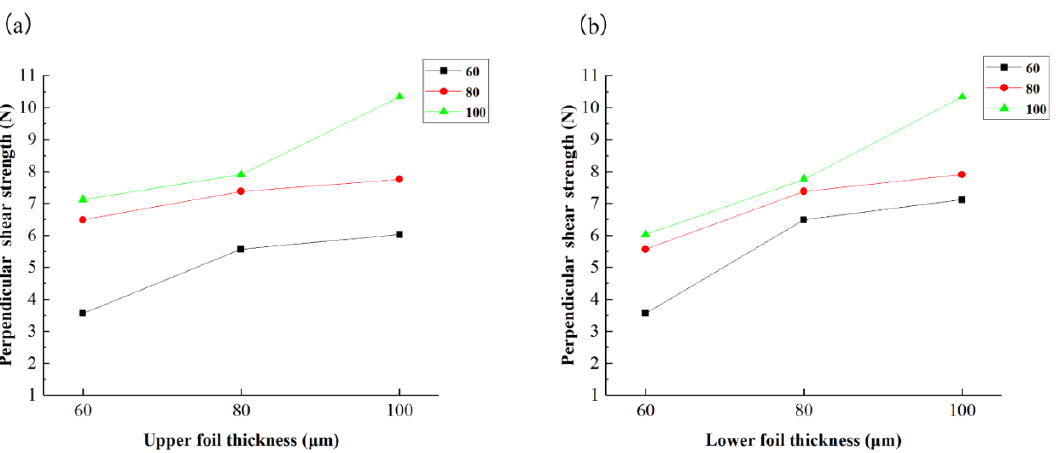
Figure 24. Parallel shear strength of different thickness combinations: ( a ) influence of upper foil thickness and ( b ) influence of lower foil thickness.